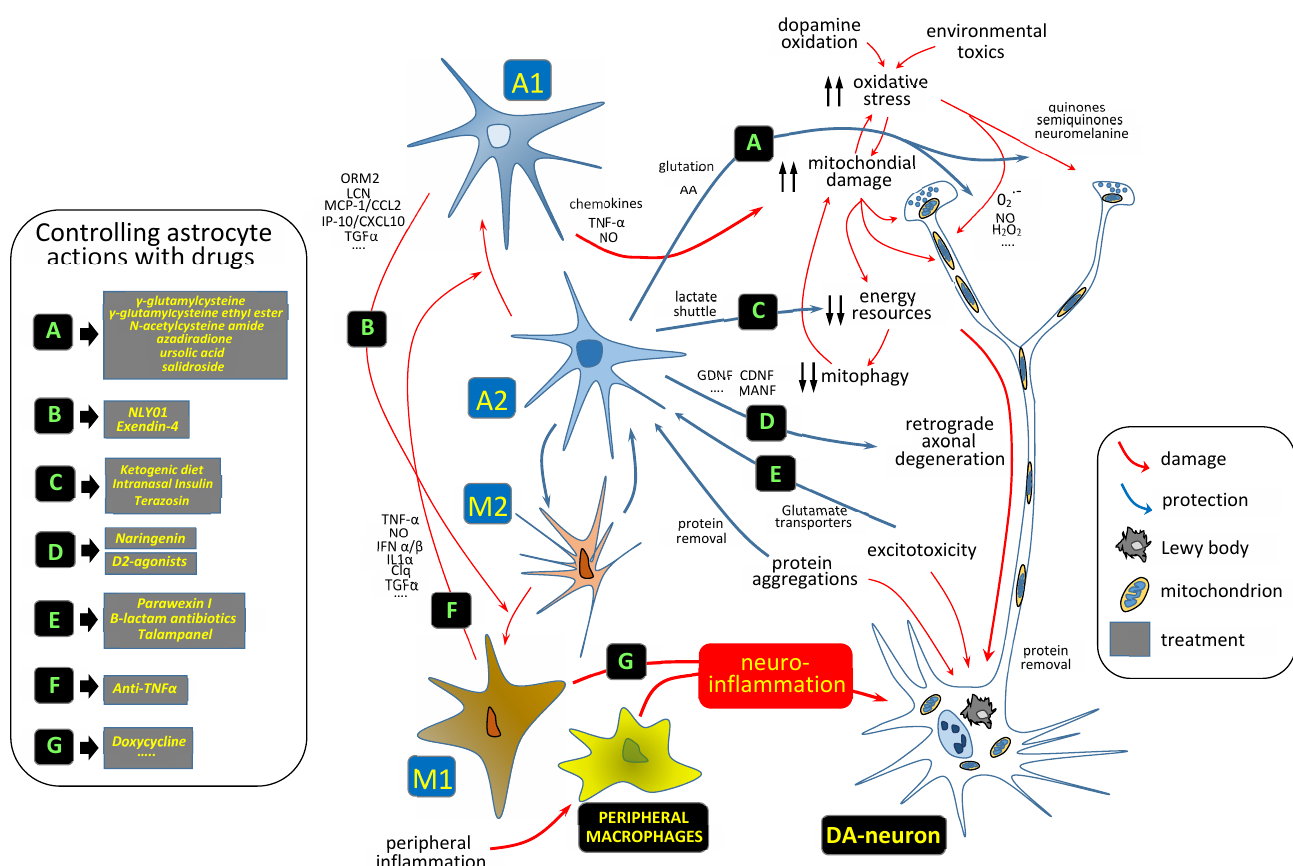
Figure 2. DA-cell interactions with astrocytes and microglia, and possible treatments to facilitate neuroprotection and to prevent neurodegeneration of DA-cells. ORM2: α -1-acid glycoprotein 2 precursor; LCN: lipocalin; MCP-1/CCL2: monocyte chemoattractant protein-1; IP10/CXCL10: interferon-gamma inducible protein; TGF α : transforming growth factor α ; TNF α : tumor necrosis factor α ; NO: nitric oxide; IFN α / β : alpha/beta interferon; IL1 α : interleukin-1 α ; CLq: component of the complement initiator C1 complex; AA: ascorbic acid; GDNF: glial cell line-derived neurotrophic factor; CDNF: cerebral dopamine neurotrophic factor; MANF: mesencephalic astrocyte-derived neurotrophic factor; Glu: